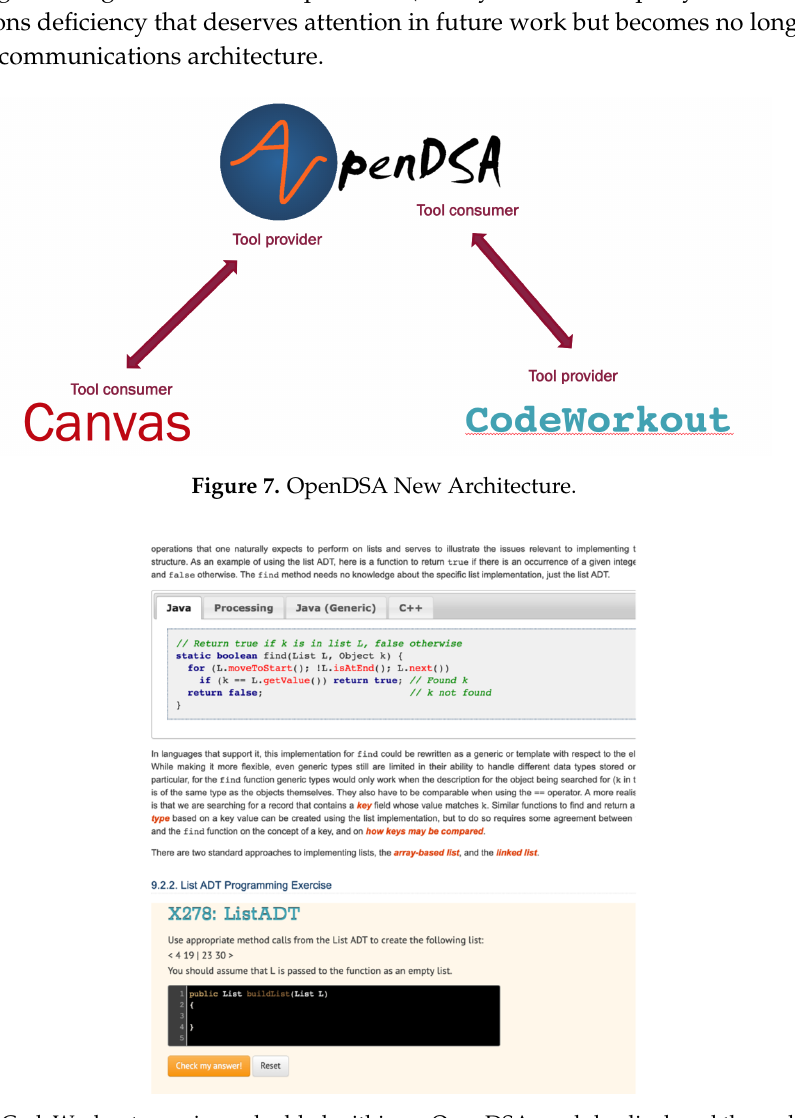
Figure 8. A CodeWorkout exercise embedded within an OpenDSA module, displayed through